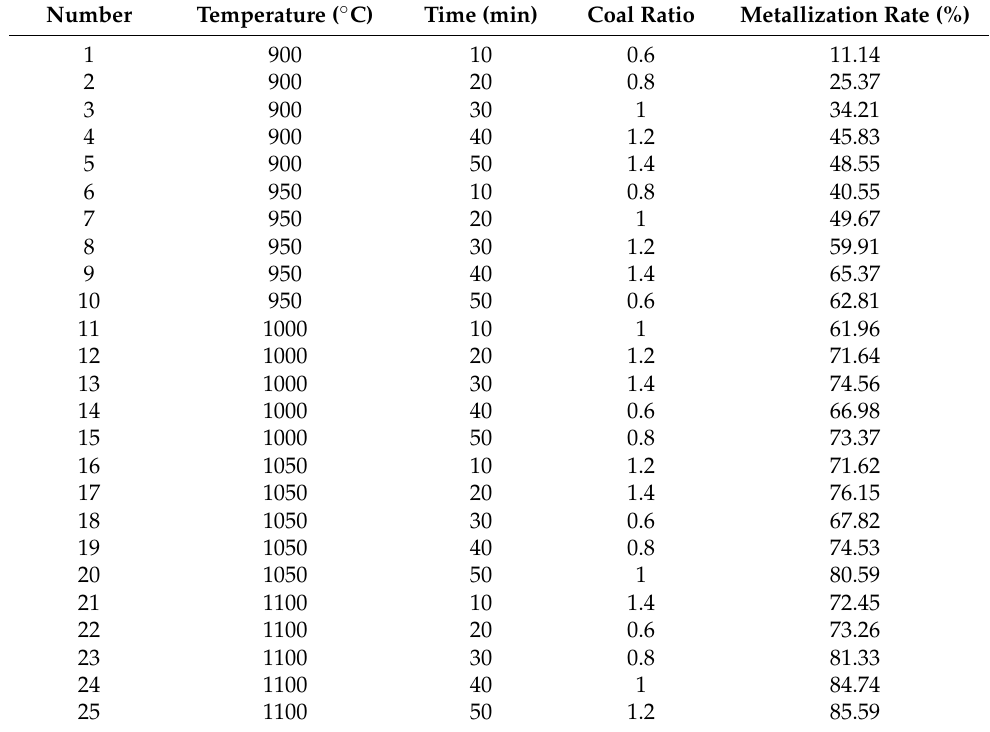
Table 4. Results of the orthogonal metallizing test.